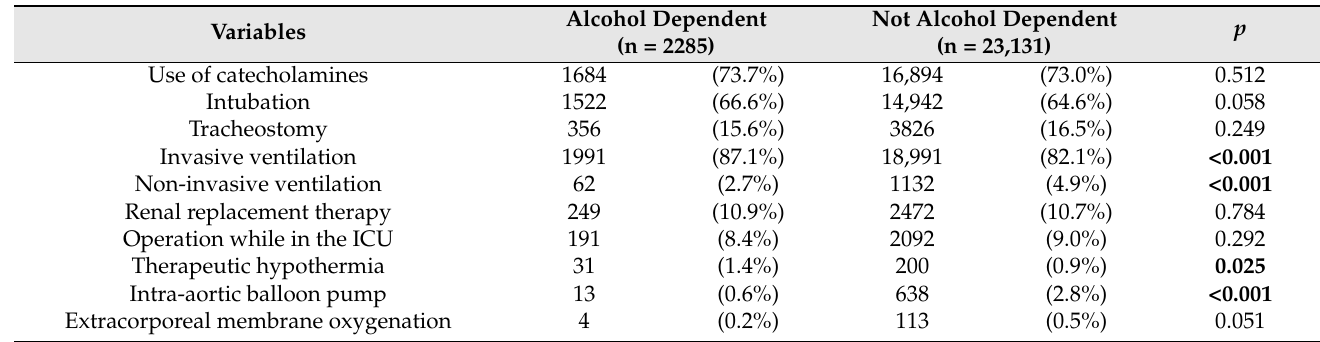
Table 3. ICU treatment in patients with or without